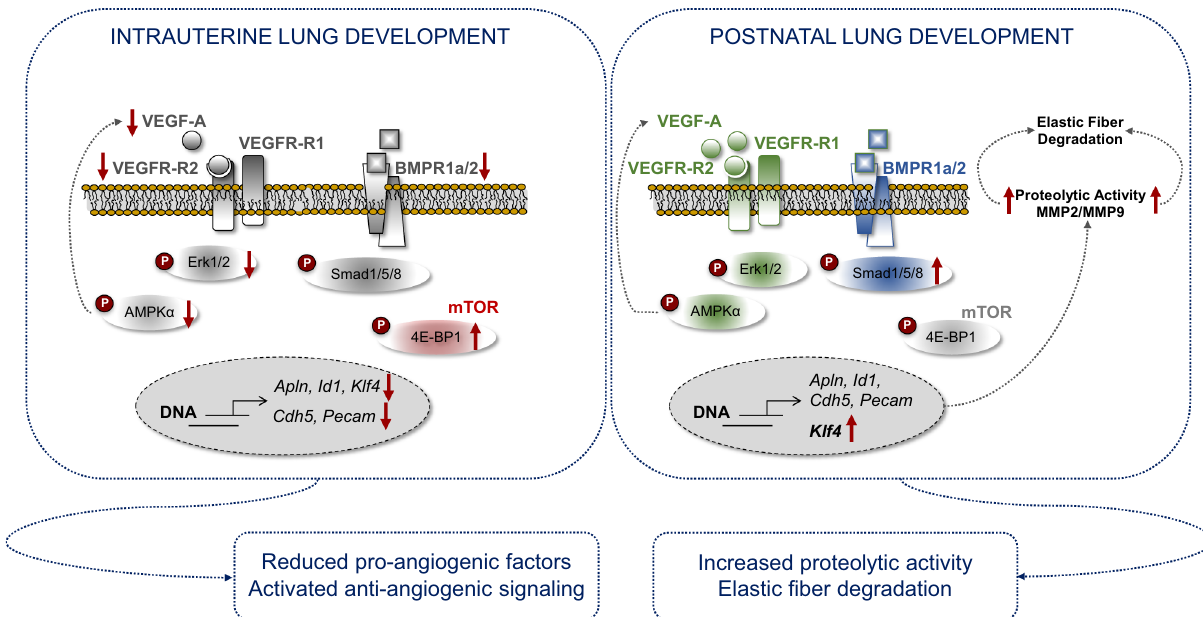
Figure 7. Speculative working model of two-step perinatal microvascular programming after intrauterine growth restriction (IUGR) with low birth weight (LBW). Fetal genetic factors contribute to low birth, linked to reduced lung function later in life. Intrauterine phase : IUGR inhibits angiogenic signaling, including vascular endothelial growth factor (VEGF), AMP-Activated protein kinase (AMPK)α, and bone morphogenetic protein (BMP) signaling, whereas the anti-angiogenic mechanistic Target of Rapamycin (mTOR) signaling is activated. Postnatal phase : transient activation of angiogenic signaling; the loss of elastic fibres is associated with increased proteolytic activity after IUGR. Both intrauterine and postnatal phase are related to reduced microvascular formation in lungs after IUGR and could account for the reduced lung function determined in infants born with low birth weight using Mendelian